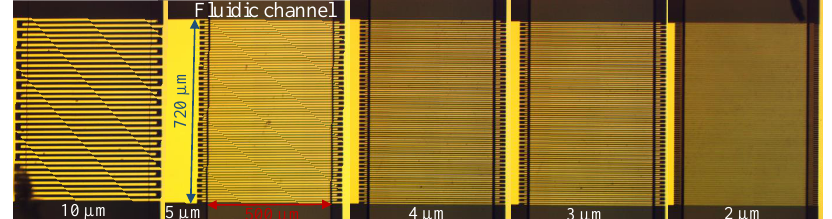
Figure 5. Microscope photograph of the fabricated IDC sensors with different dimensions of electrode width and gap width between